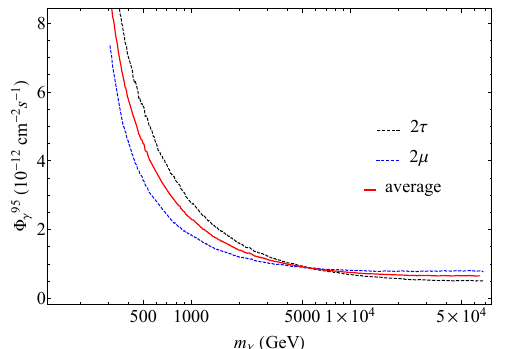
in the energy range (cid:13)